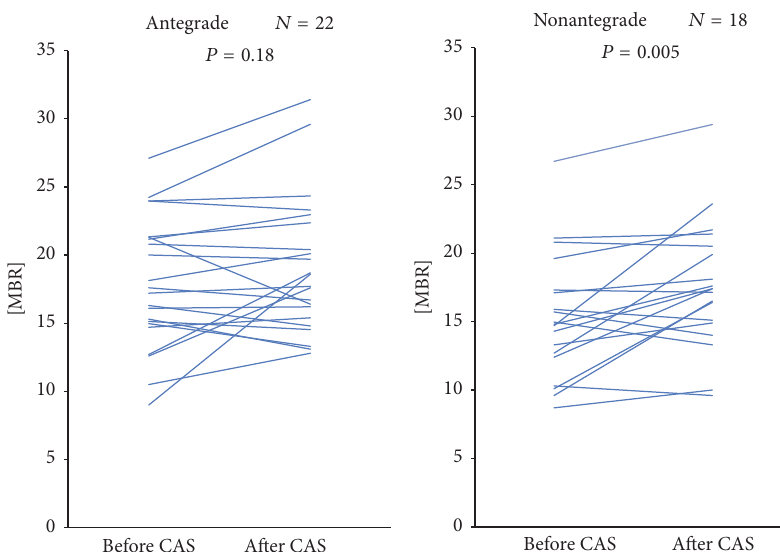
Figure 6: Change in the MBR before and after CAS in the antegrade and nonantegrade groups. There was the significant rise in the MBR in the nonantegrade group ( 𝑃 = 0.005